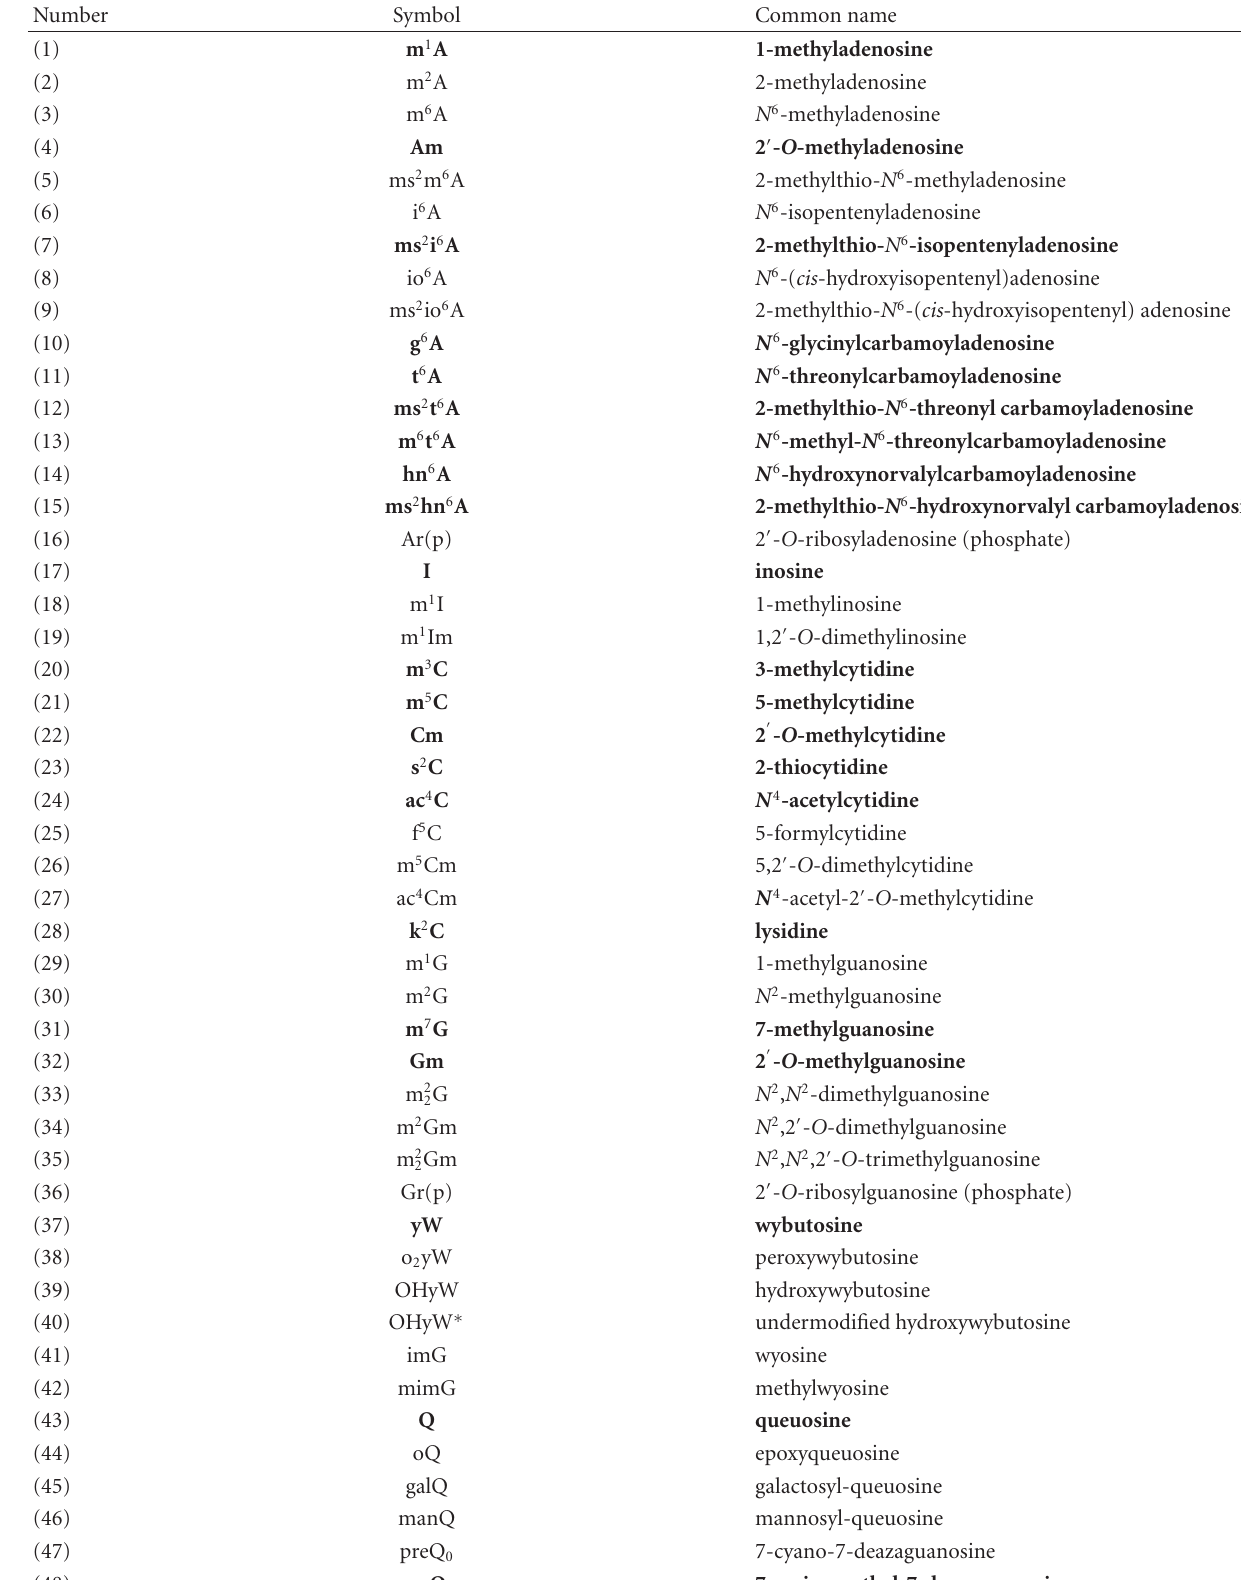
Table 1: Known RNA modifications and their abbreviations and symbols (modified nucleosides mentioned in the text are indicated in